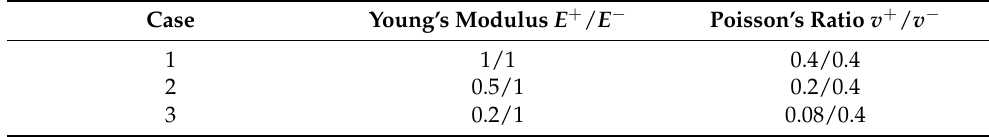
Table 3. Tensile and compressive modulus and Poisson’s ratio. Figure 10. Semi-infinite model with linearly distributed vertical load: ( a ) semi-infinite model with 12 blocks by FBM; ( b ) side view from x-axis.